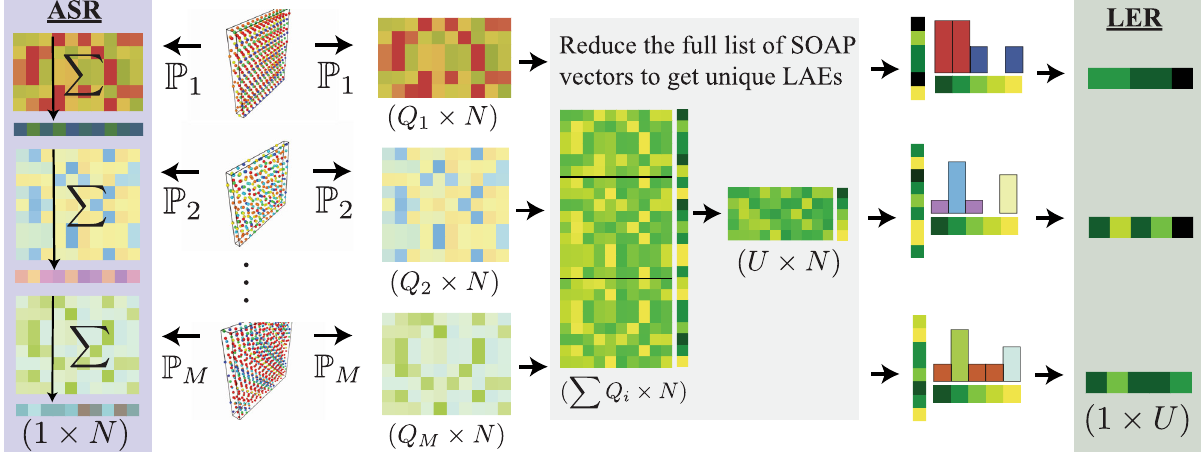
Fig. 2 Illustration of the process for construction of the ASR and LER for a collection of GBs. First, a SOAP matrix P is formed (as shown in Fig. 1). ASR: A sum down each of the Q columns in the matrix produces an averaged SOAP vector that is representative of the whole GB. The ASR feature matrix is then the collection of averaged SOAP vectors for all M GBs of interest ( M × N ). LER: The SOAP vectors from all M GBs in the collection are grouped together and reduced to a set U of unique vectors using the SOAP similarity metric, of which each unique vector represents a unique LAE. A histogram can then be constructed for each GB counting how many examples of each unique vector are present in the GB. This histogram produces a new vector (the LER) of fractional abundances, whose components sum to 1. The LER feature matrix is then the collection of histograms of unique LEA for the M GBs in the collection ( M × U )